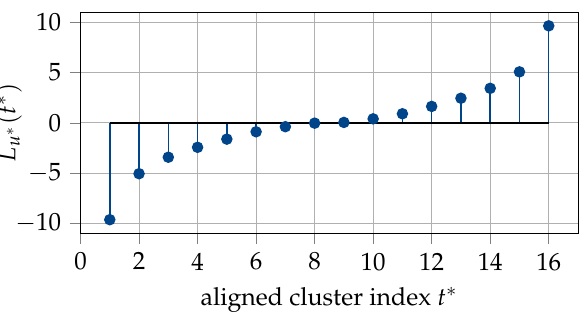
Figure 11. Translation table for aligned decoding tables at the decision level with |T ∗ | = 16 for the polar code with N = 128, rate = 0.5 and design E b / N 0 = 3